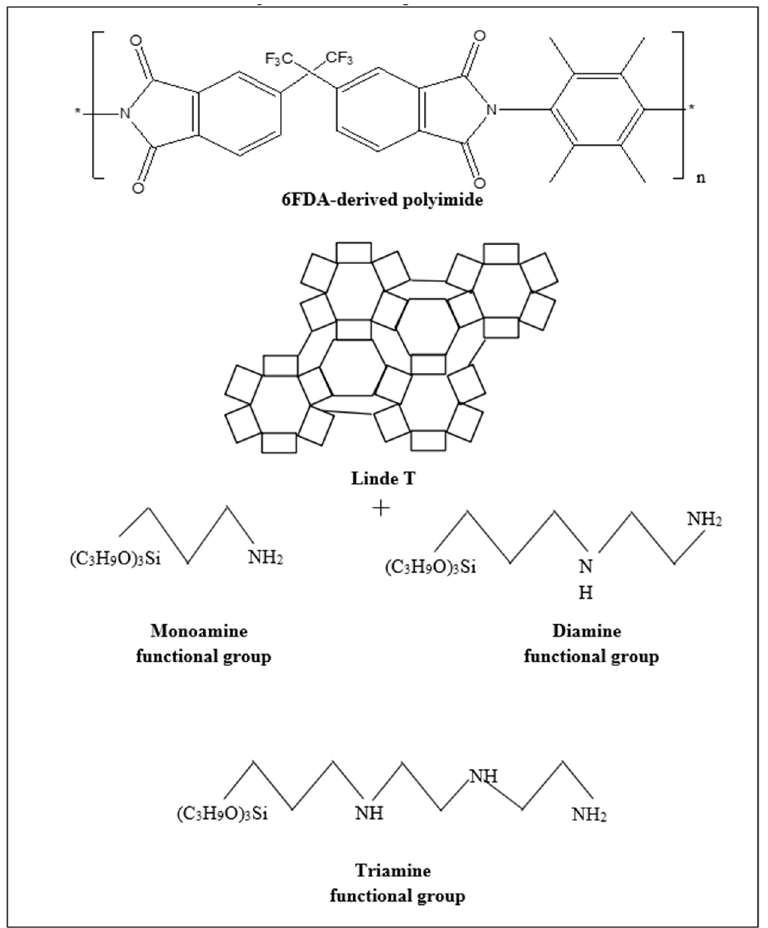
Figure 1. The chemical structures of 6FDA-derived polyimide, Linde T, and amine-functionalization groups, including monoamine (APTMS), diamine (AAPTMS), and triamine (AEPTMS) functional groups, adapted from Nafisi & Hägg (2014) and Huh et al. (2003) [40,41]. Particles were then recovered through centrifugation and washed with methanol to eradicate the unreacted silane after completion of the chemical modification process. The impregnated zeolite